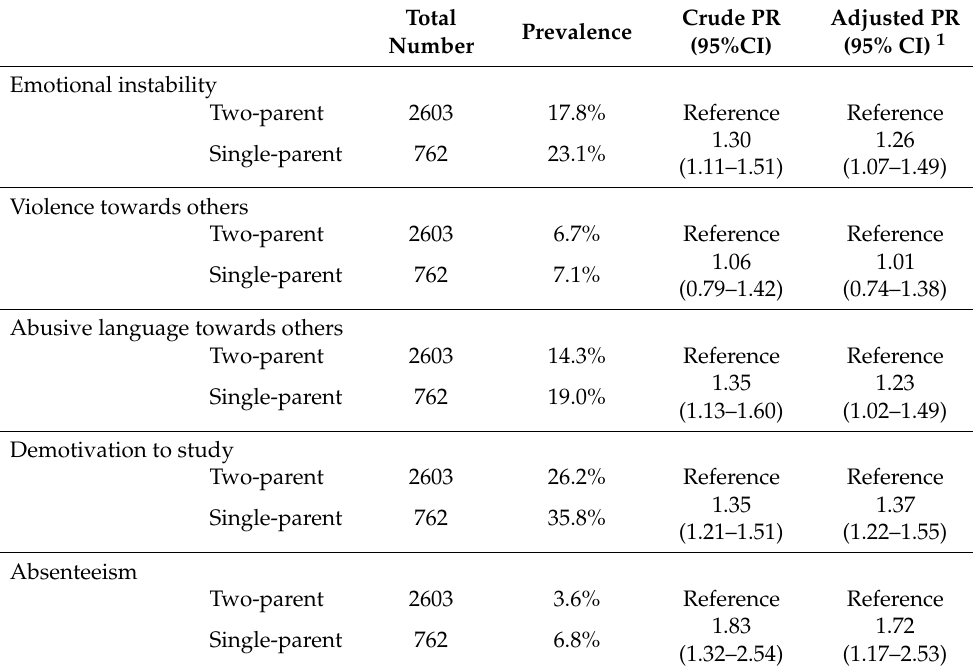
Table 2. Association between family type and children’s outcome (emotional instability and misbe- haviors) ( n =